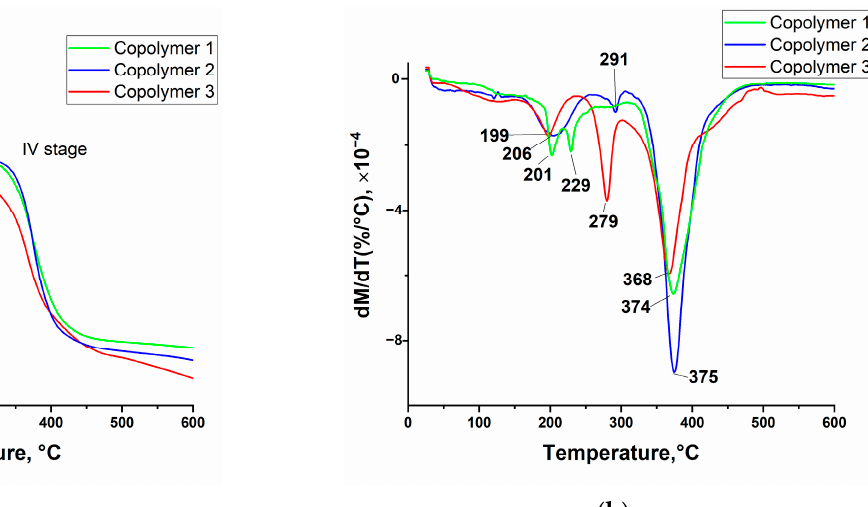
( B ) Figure 3. SAXS ( A ) and WAXS ( B ) of copolymers with 1 wt.% CoAcr 2 PhTpy: copolymer 1— AAm/AAc 84.5/14.5; copolymer 2—AAm/AAc = 49.5/49.5; copolymer 3—AAm/AAc = 14.5/84.5. 3.1.4. Thermal Properties of Polymers According to the TGA and DTG curves (Table 3, Figure 4), the obtained copolymers decomposed in four main stages. The first stage proceeded monotonically up to 100–130 °C, with a weight loss of no more than 2–3 wt.% and was accompanied by a significant endothermic effect on DSC (Figure 5). This is due to the loss of physically adsorbed water molecules ( m / z = 18; 17) according to ion-fragmentation mass spectrometry. Weight loss up to 15 wt.% was observed in the second stage from 150 to 240 °C, with maximum de- composition rates from 199 to 229 °C. The third stage of decomposition proceeded at a